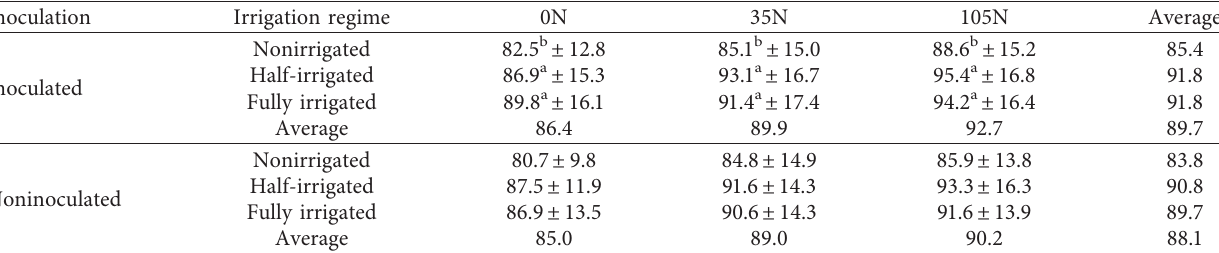
Table 9: The effect of different fertilization treatments on LAI of soybean (cv. Bogl´ar) under different irrigation regimes, averaged among 2017, 2018, and 2019 in Debrecen, Hungary.